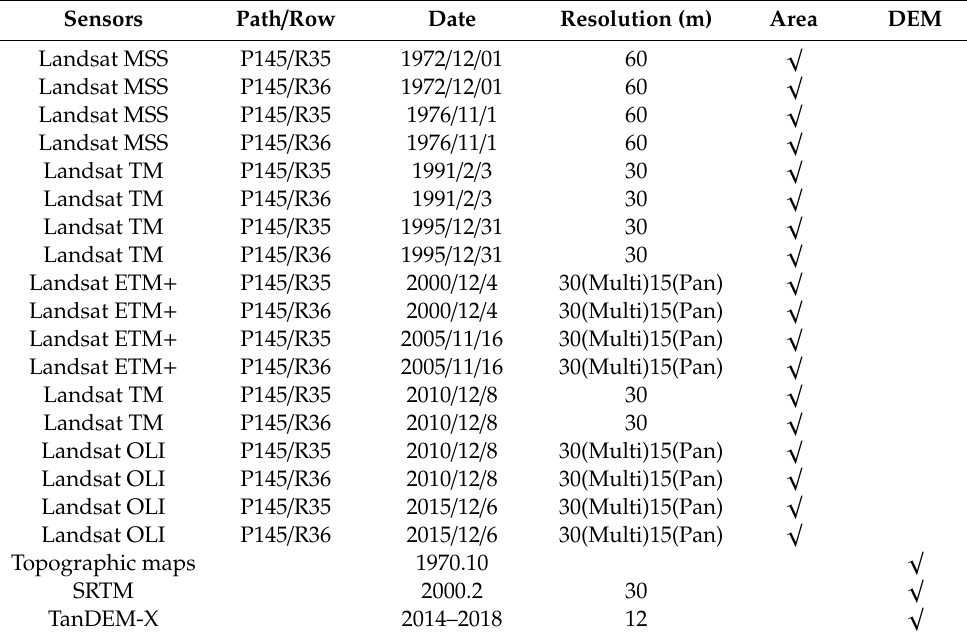
Table 1. The remote sensing data selected in this